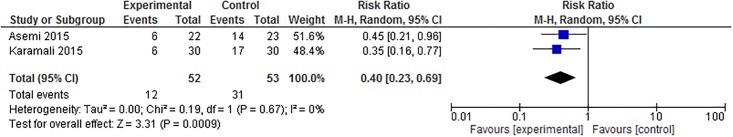
Meta Analysis of complications in the newborn (occurrence of hyperbilirubinemia).